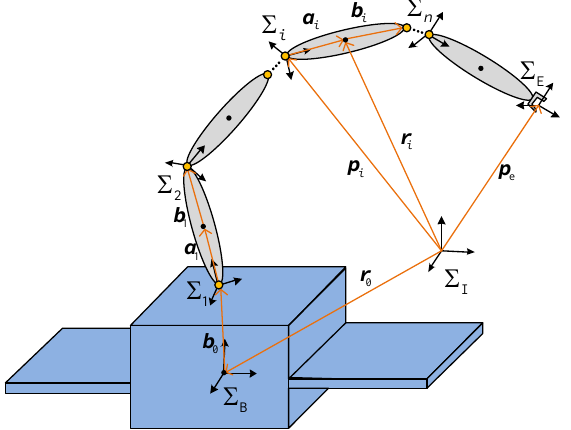
Figure 1. A general model of free-floating space robot.